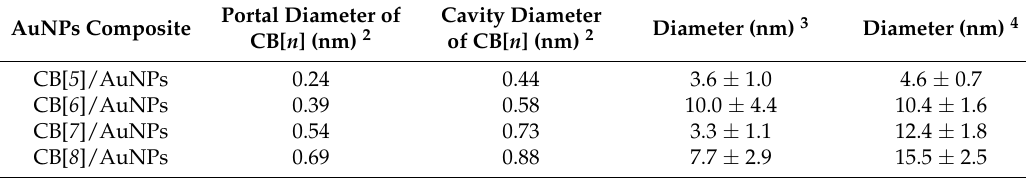
Table 1. TEM determined particle sizes for AuNPs prepared in situ by CB[n] 1 .